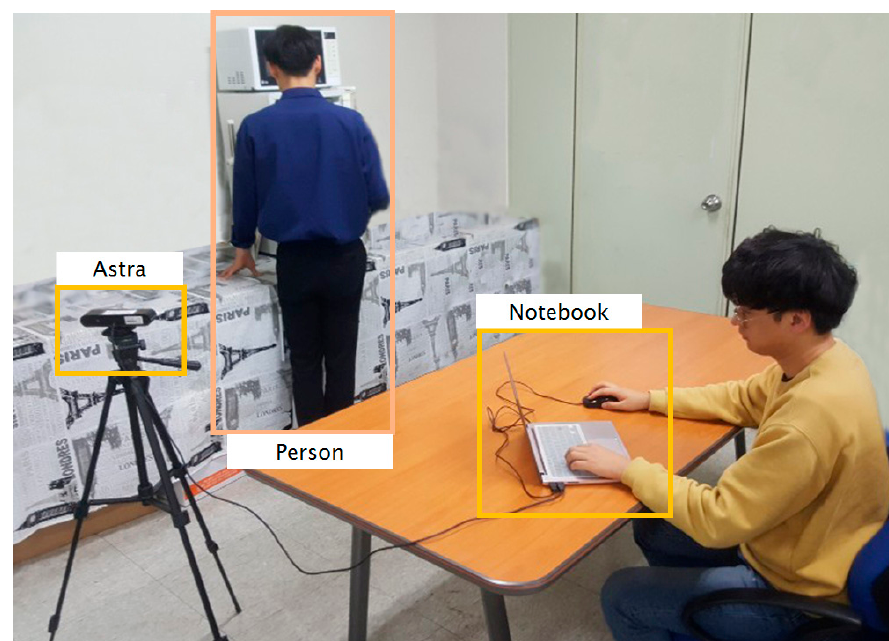
Figure 9. Environment for capturing posture images using Astra.